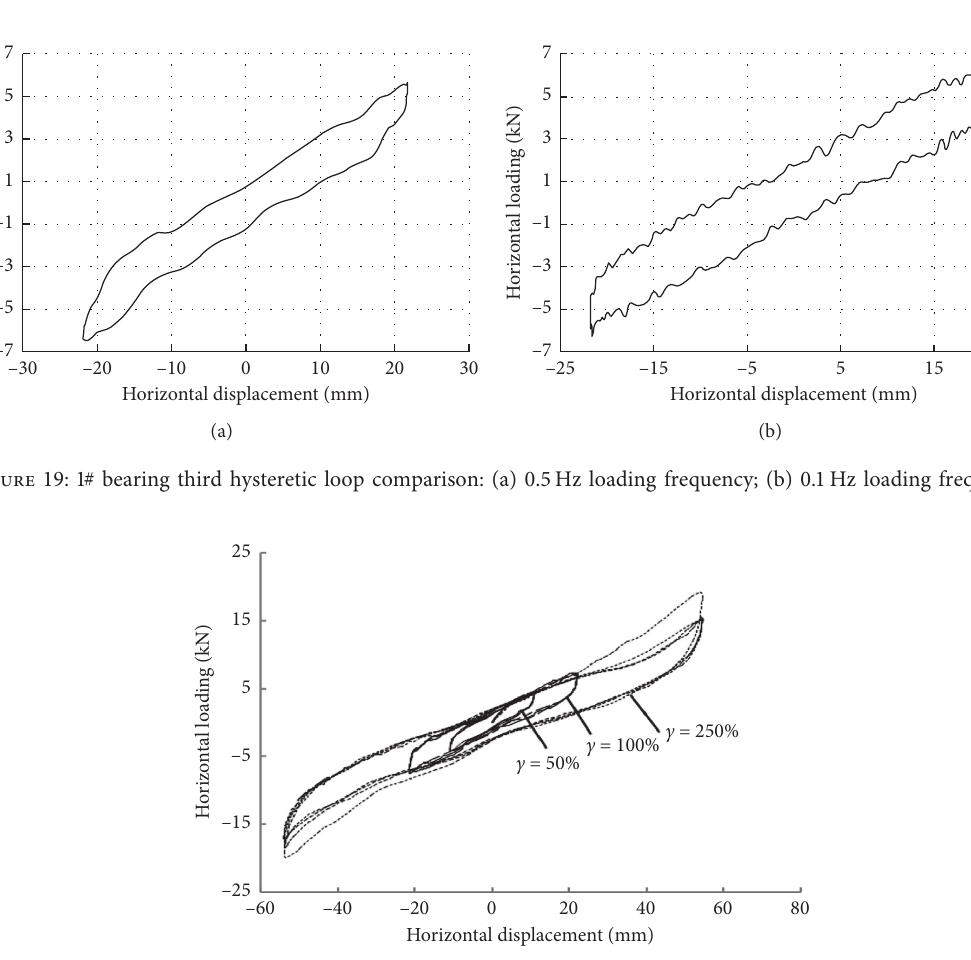
Figure 20: GZ5-0.5 hysteretic curves with varying shear